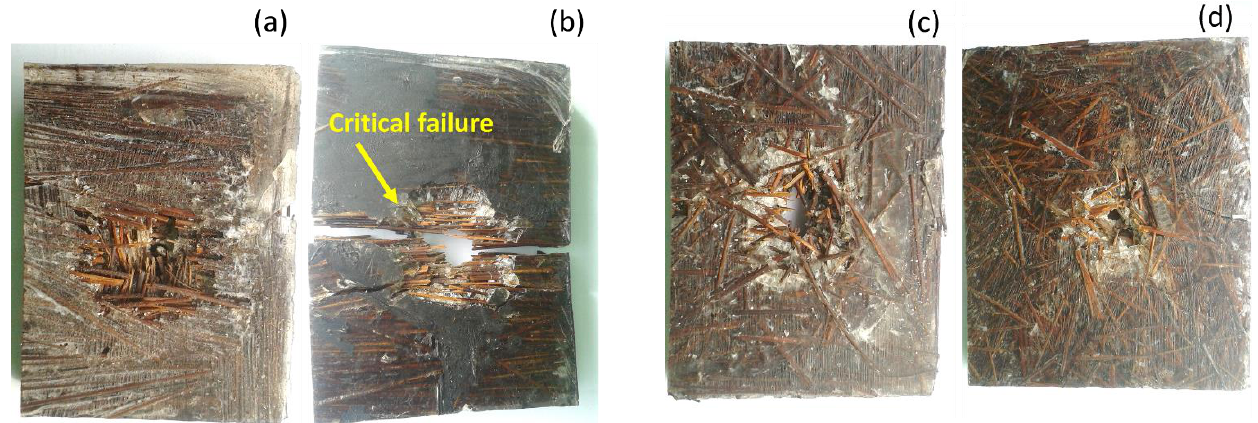
Figure 4. Macroscopic aspect of failure after ballistic impact ( a ) LA2D; ( b ) LA1D; ( c ) LRS, and ( d ) SRS.